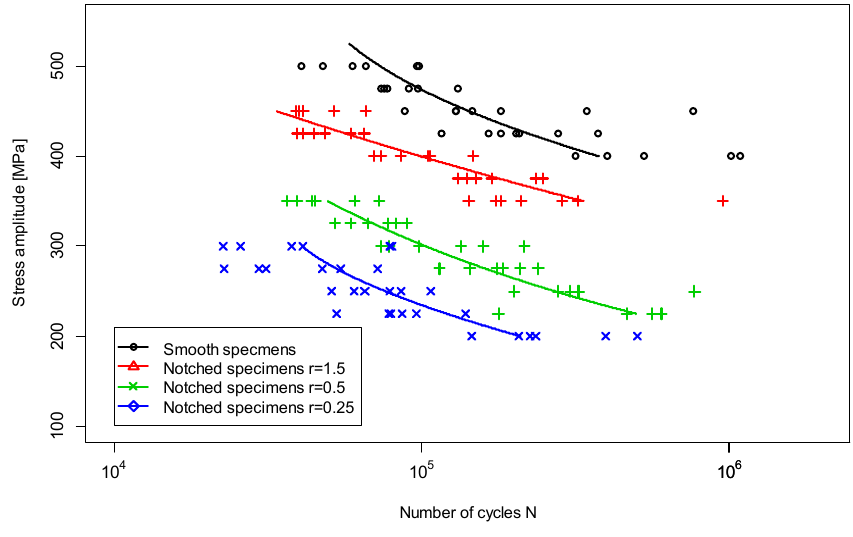
Figure 6. S–N curves for 1.4301 steel.